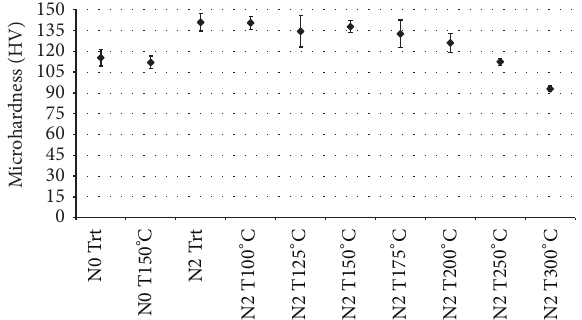
Figure 5: Microhardness values for the different forged